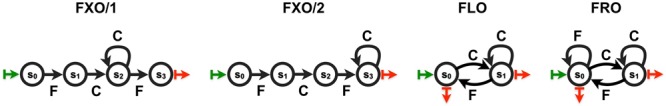
State-transition diagrams of the non-deterministic finite-state automata generating strings from the grammars used in the present study. Circles are states, and black arrows are transitions between states. The initial and final states are indicated by green and red arrows, respectively. At every transition, a symbol from the F or C types is generated. All strings used in the present study had a minimum length of 3 words: we considered only (a subset of) the strings that can be generated after 3 or more transitions.